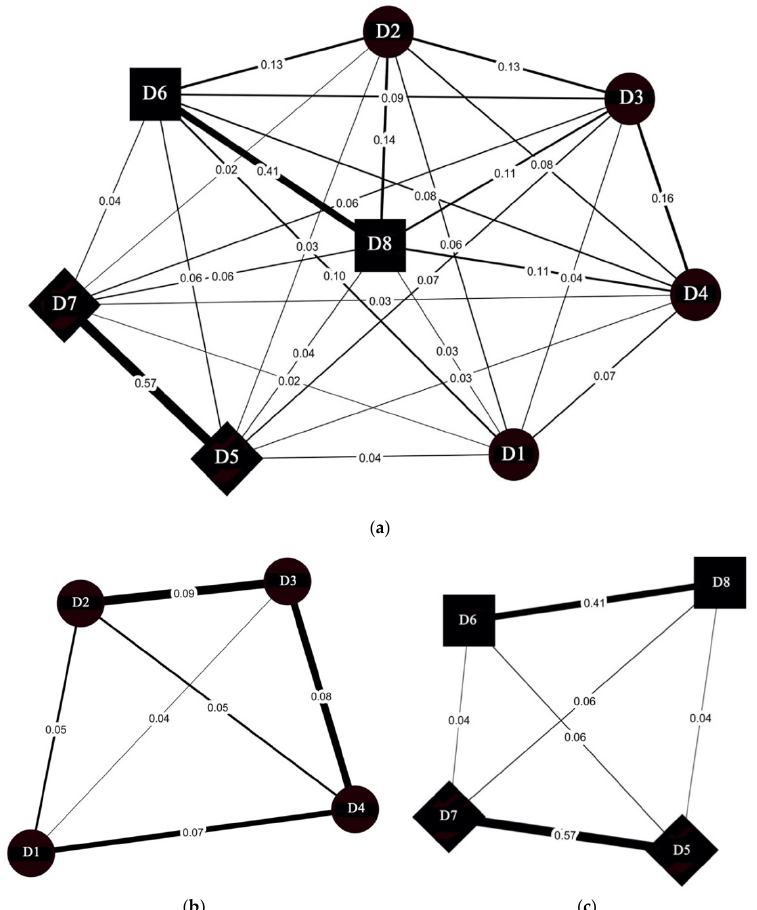
Figure 2. Three networks for dolphins in various groups. Thicker lines (edges) indicate a stronger tie between the two individuals (nodes). Mother–calf dyads are indicated by matching square nodes and diamond nodes. Individuals not part of a mother–calf dyad are indicated by circles. ( a ) Network representing time periods when all eight dolphins were accessible to each other. ( b ) Network representing time periods when D1, D2, D3, and D4 were separated as a subgroup. ( c ) Network representing time periods when D5, D6, D7, and D8 were separated as a subgroup. tween blocks 6 and 22 despite being older than D5.